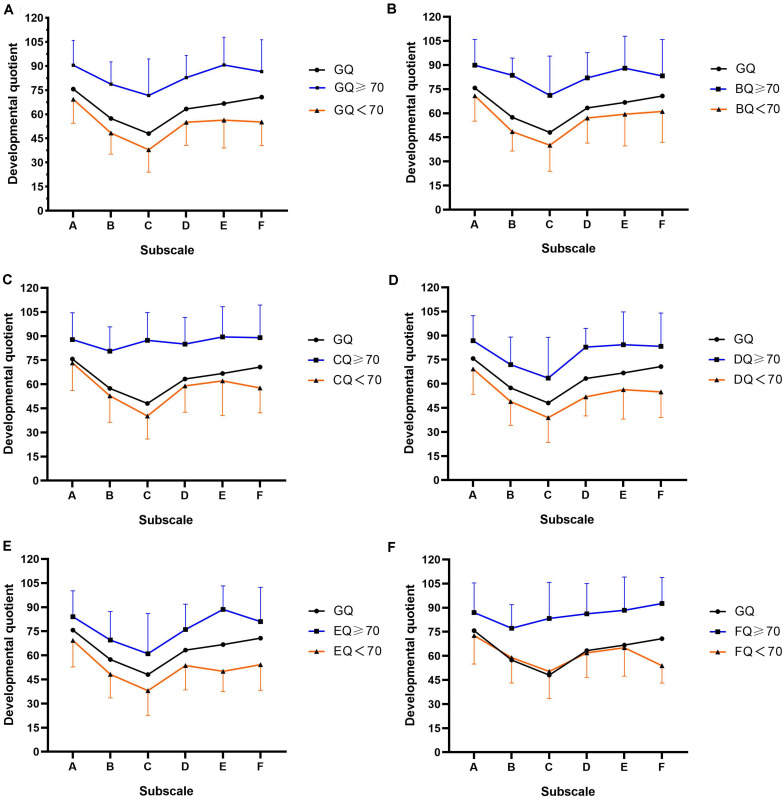
Developmental profiles of autistic children included in this study plotted according to the two categorized developmental levels and grouped by GQ or subscale quotients. (A) Mean GMDS subscale GQ scores for the whole group and for each developmental level. Mean GQ score and mean developmental quotients on the subscales in the two levels grouped by: (B) GMDS subscale B (personal–social, BQ), (C) GMDS subscale C (hearing and language, CQ), (D) GMDS subscale D (eye–hand coordination, DQ), (E) GMDS subscale E (performance, EQ), (F) GMDS subscale F (practical reasoning, FQ). Standard deviations of the mean are represented in the figure by the error bars attached to each line of the two developmental levels.